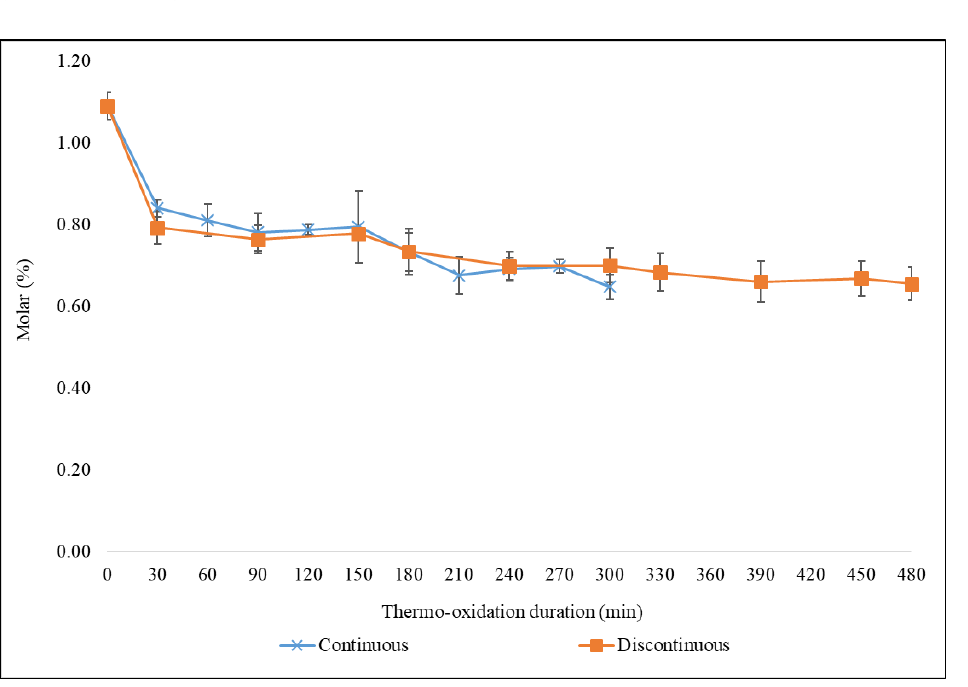
Figure 7. Changes in butyric acid/ester acyl groups of ghee subjected to a continuous and discon- tinuous thermo-oxidation at 180 °C for 300 and 480 min, respectively. The values are presented as mean ± SD molar % butyric acid/ester acyl groups of ghee.